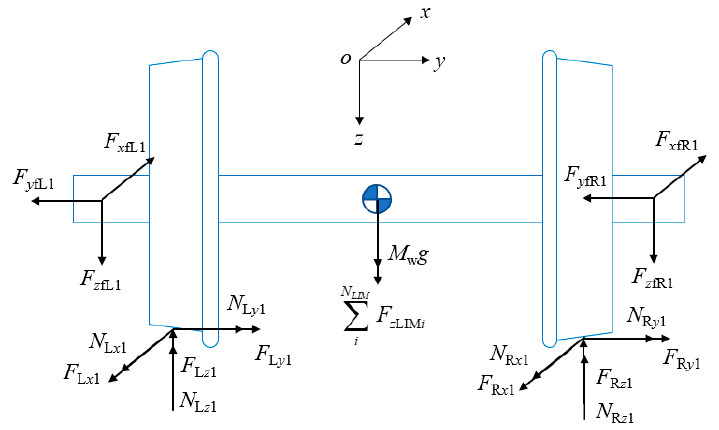
Figure 5. Force analysis of wheelset.